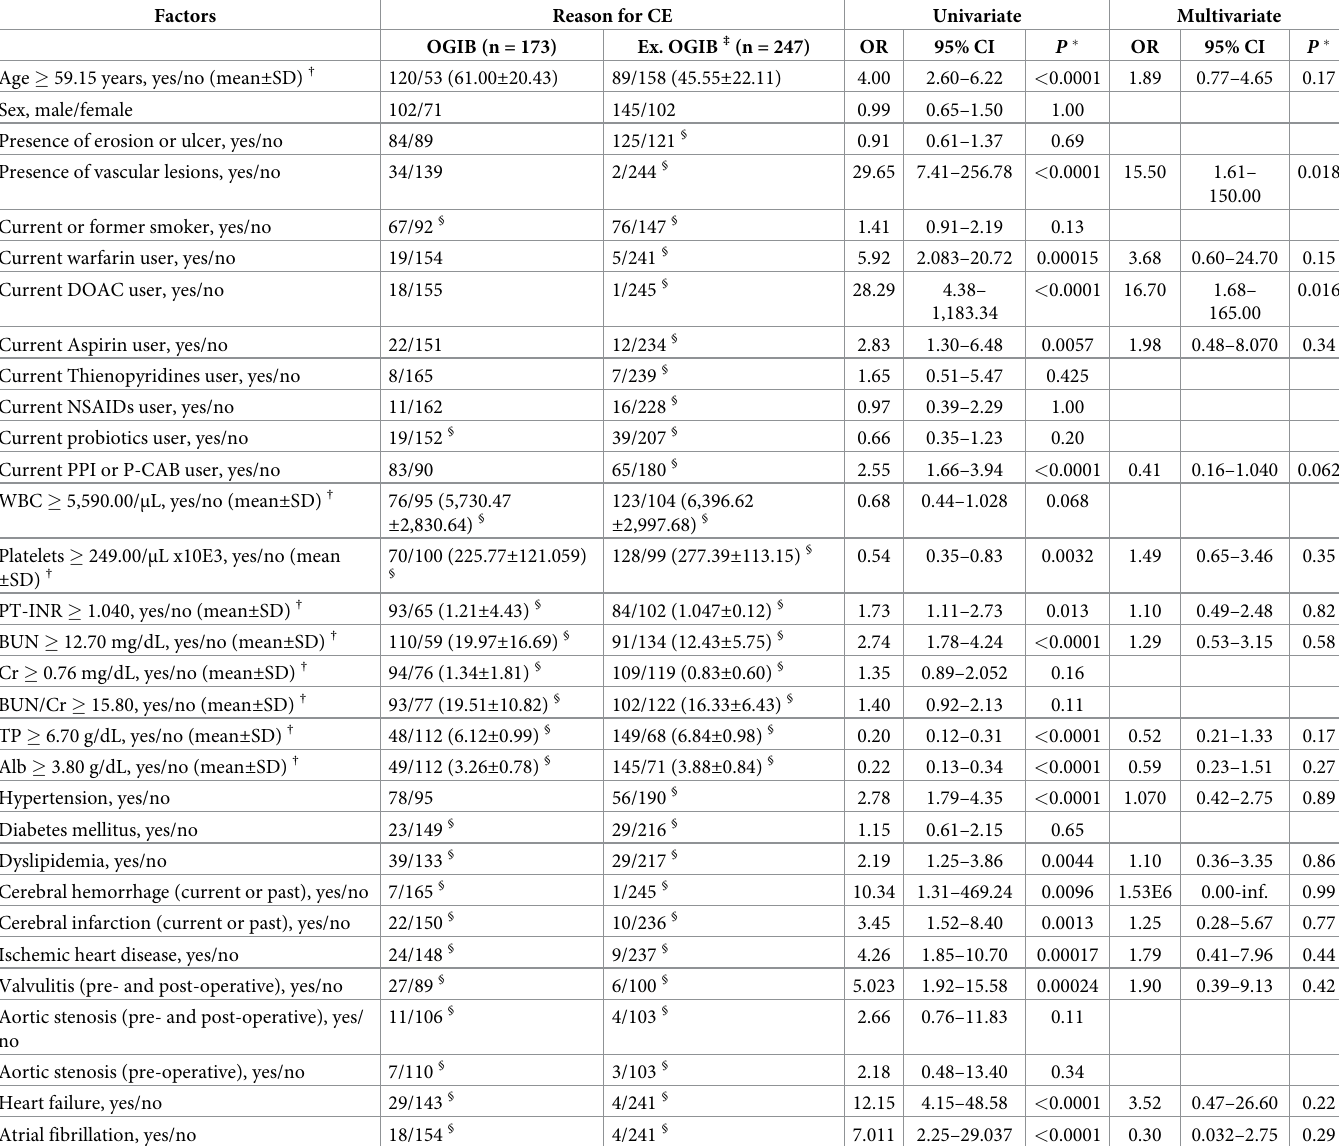
Table 2. Comparison of clinical features in patients who underwent capsule endoscopy, identified by univariate and multivariate analysis. Factors Reason for CE Univariate Multivariate OGIB (n = 173) Ex. OGIB ‡ (n = 247) OR 95% CI P � OR 95% CI P